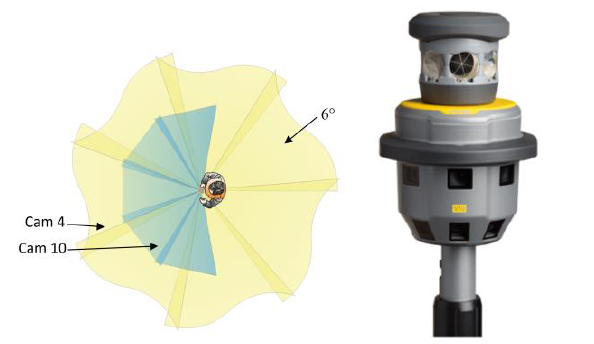
Figure 3. On the left the fields of view of the system, in yellow those relative to the upper-level cameras, that hold all 360°, in blue the 5 lower cameras that provide a 200° field of vision; on the right the Trimble V10 Imaging Rover equipped with a with a 360 degrees